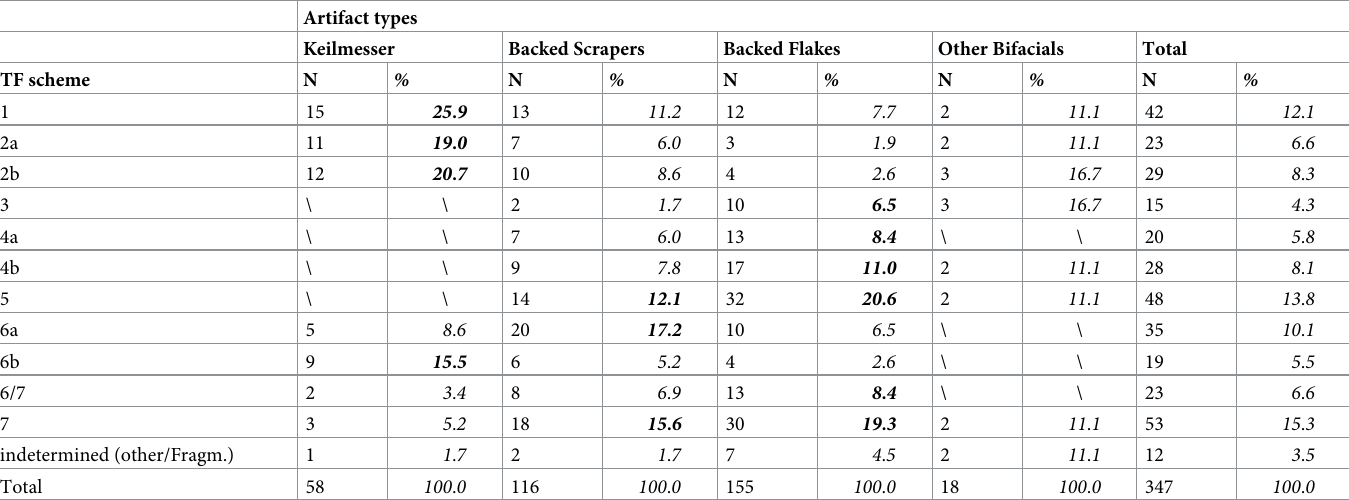
Table 6. Techno-functional schemes of tools showed for techno-typological category. Artifact types